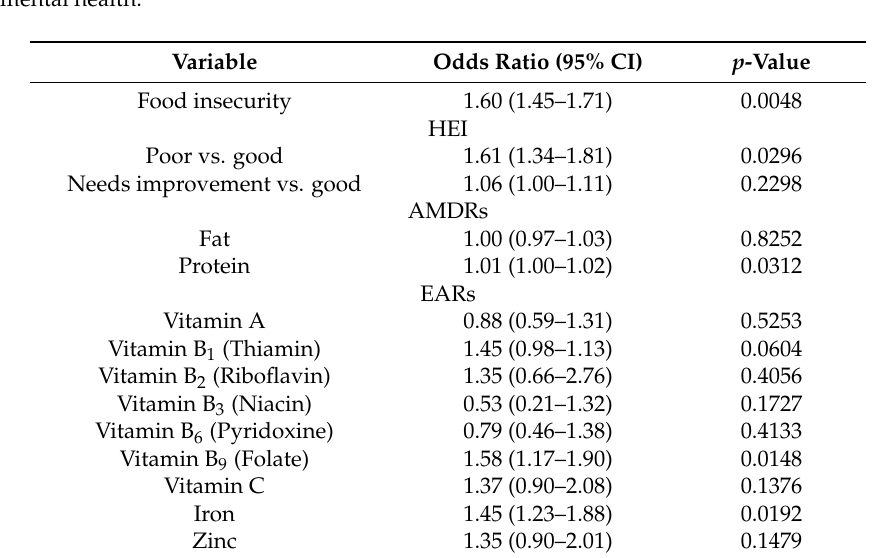
Table 2. Logistic regression estimates of food insecurity, healthy eating index (HEI), acceptable macronutrient distribution ranges (AMDRs), and estimated average requirements (EARs) in relation to poor mental